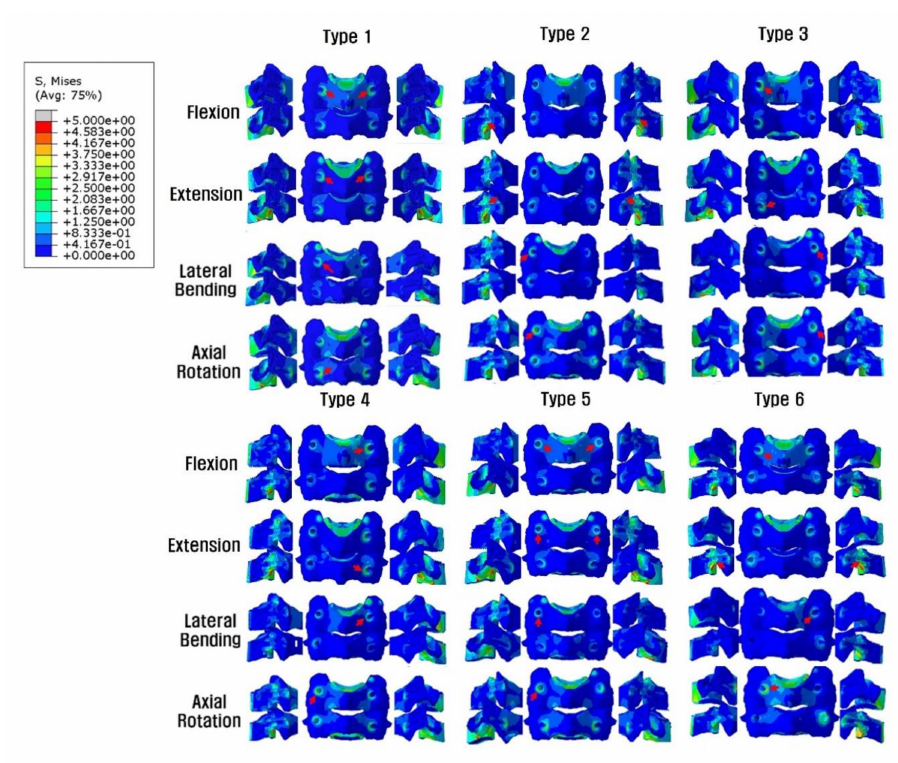
Figure 5. Posterior and lateral views of the Peak von Mises stress distributions on the screw-bone interface. On the LMS side, the stress load of the vertebral body is demonstrated, but on the PS side, the stress shielding of the vertebral body by PS is seen. *Red arrows indicate the highest